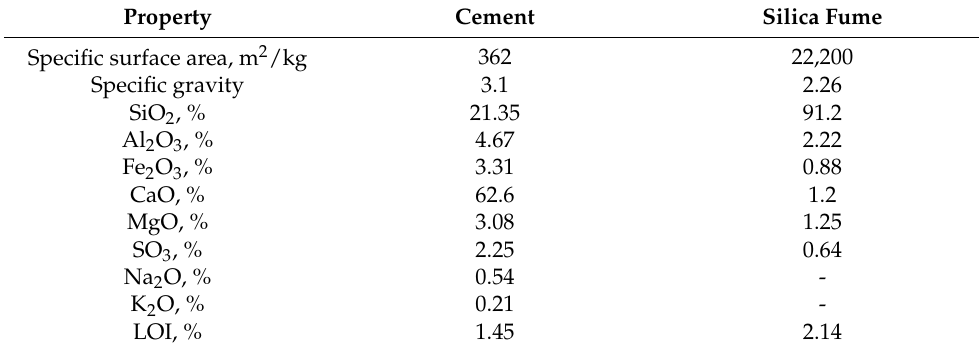
Table 1. Physical properties and chemical composition of cement and silica fume.